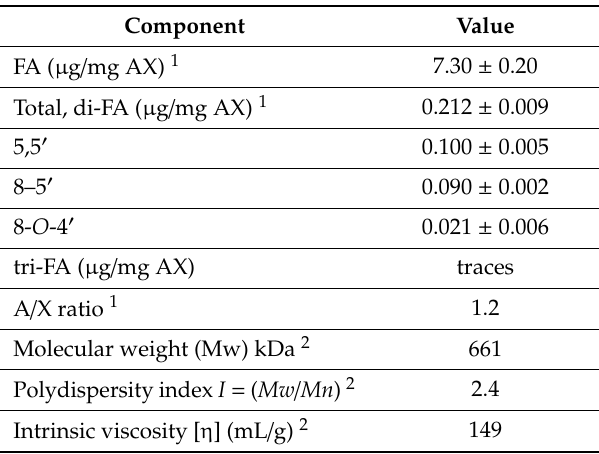
Table 1. Macromolecular characteristics of AX extracted from distillers’ grains with solubles (DDGS). Component Value